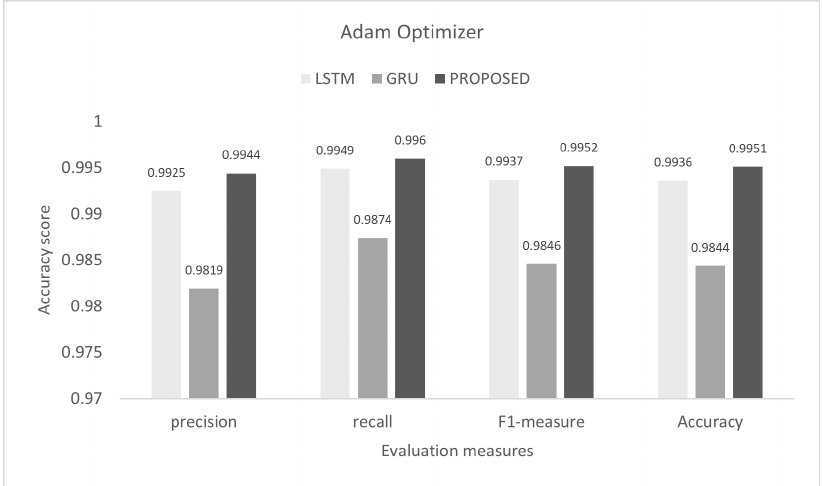
Figure 7. Evaluation on Adam with the combined DDoS